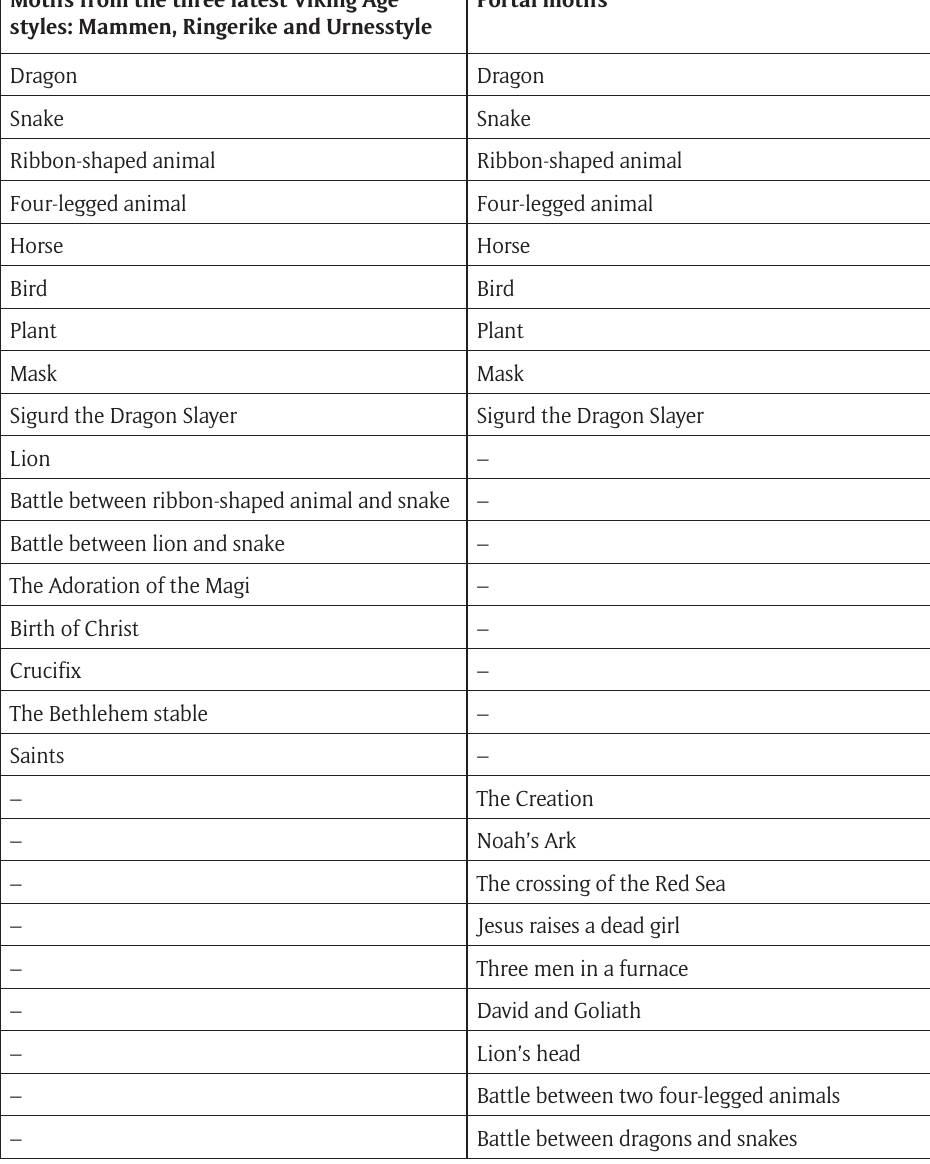
Table 3: Motifs from the late Viking period compared with motifs on the medieval